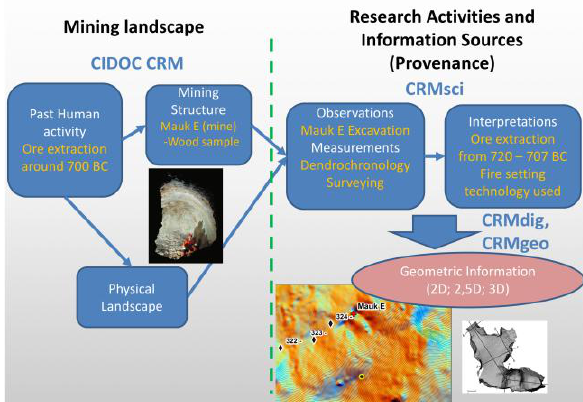
Figure 9. Example of the modeling for the mine “Mauk E”